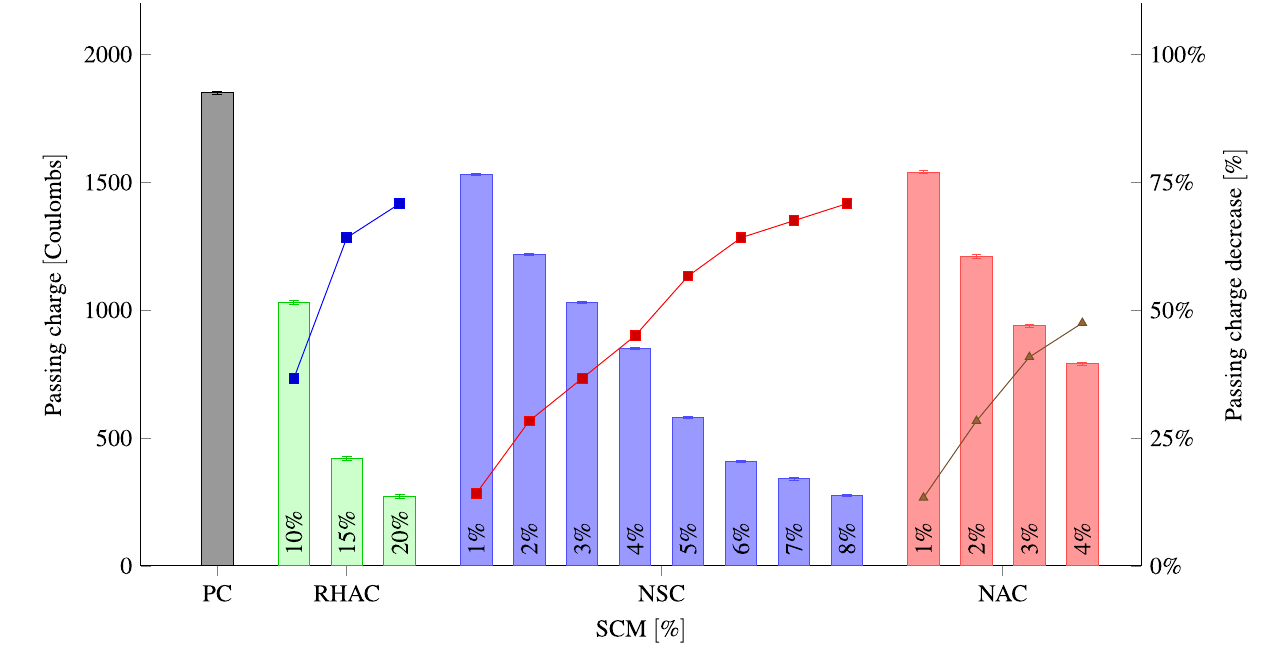
Figure 12. Rapid chloride penetrability at 28 days for different percentages of RHA, NS, NA replacement.